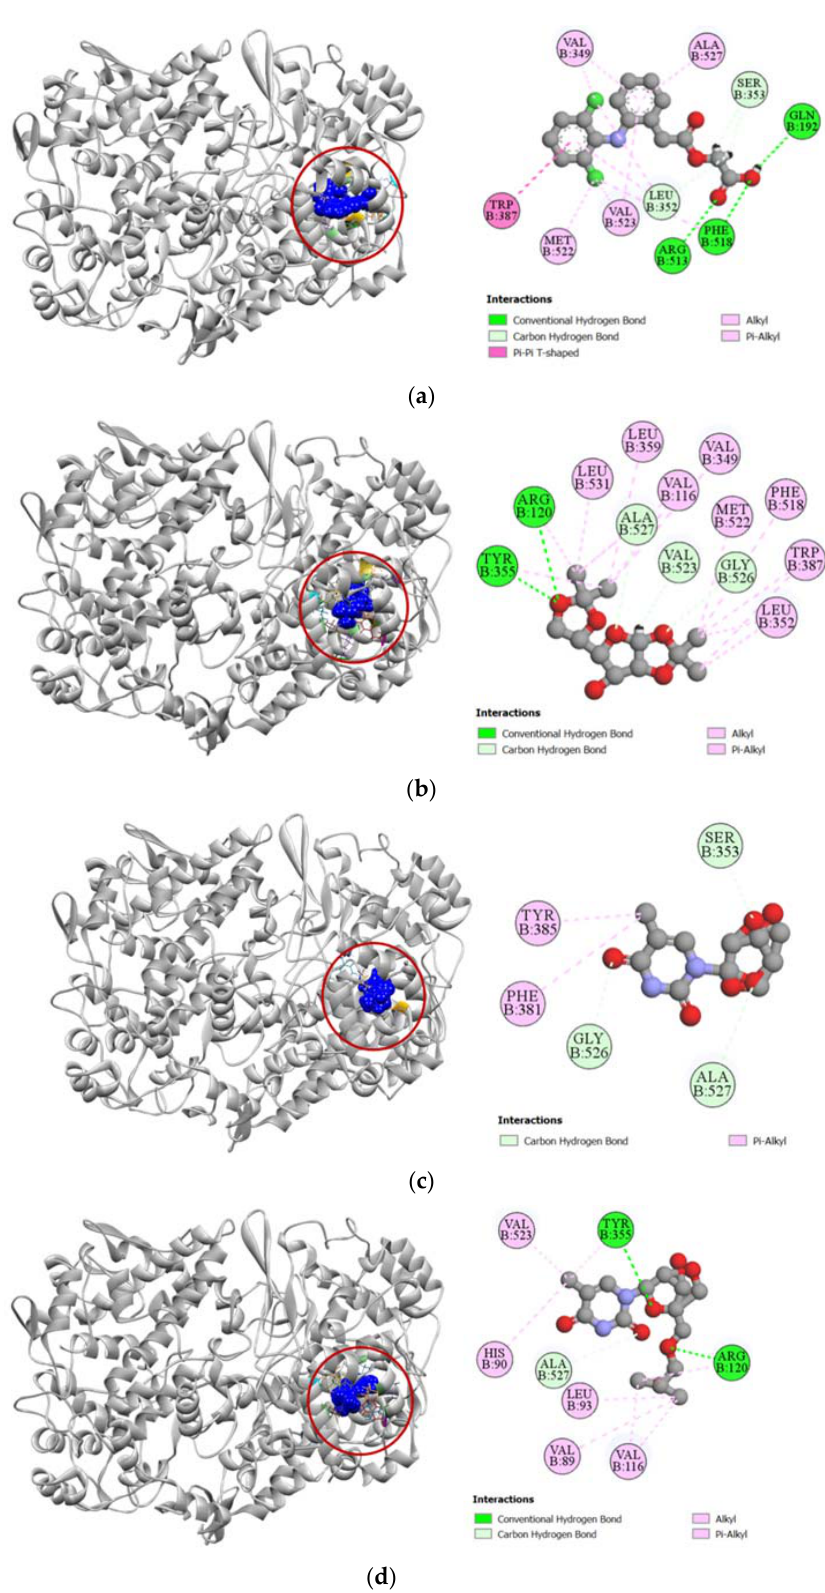
Figure 4. Pictorial representation (2D and 3D) of docking results for best-ranked pose of key interactions of ligands with the binding pocket of cyclooxygenase-2 (PDB: 5IKT). ( a ) Aceclofenac with 5IKT; ( b ) compound 2 with 5IKT; ( c ) compound 7 with 5IKT; ( d ) compound 8 with 5IKT.